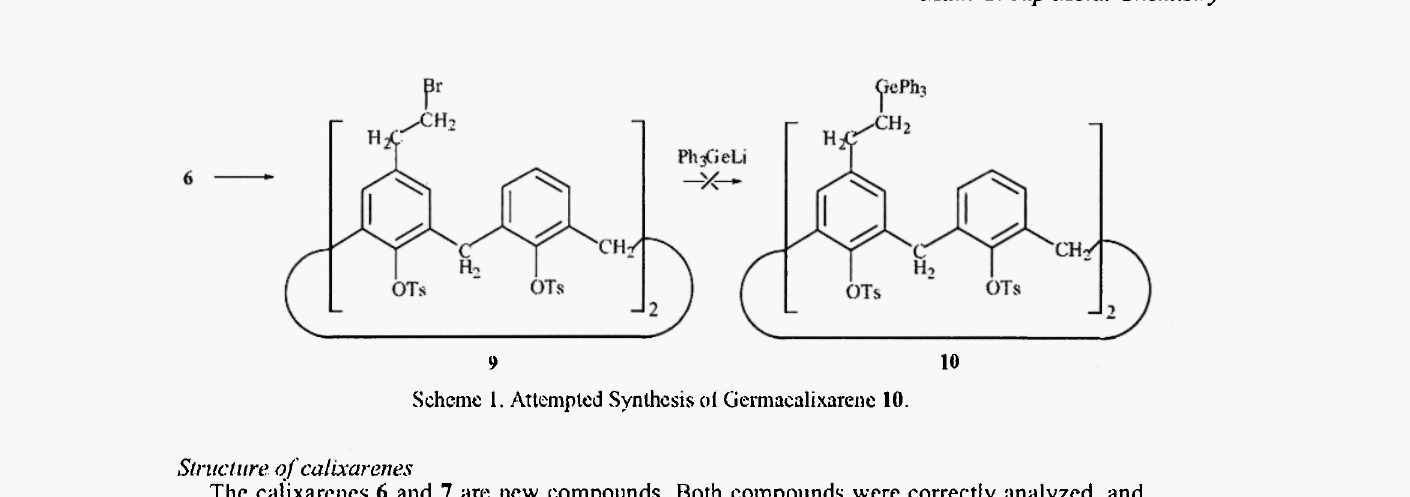
Scheme 1. Attempted Synthesis olüermaealixarene 10.